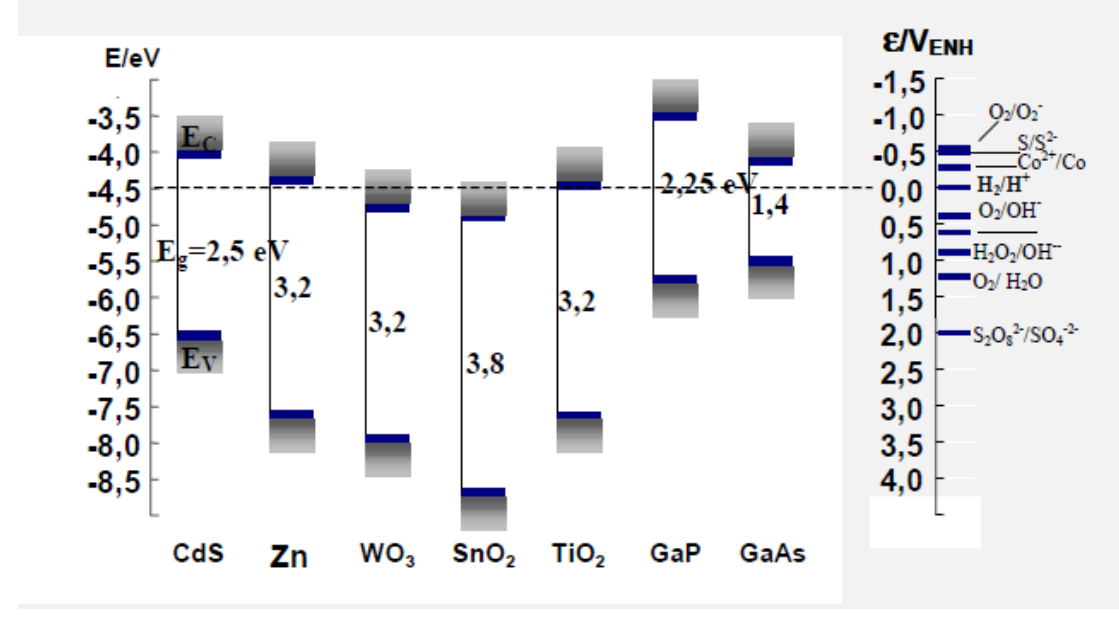
Figure 2. Diagram of conduction and valence band for various semiconductors.